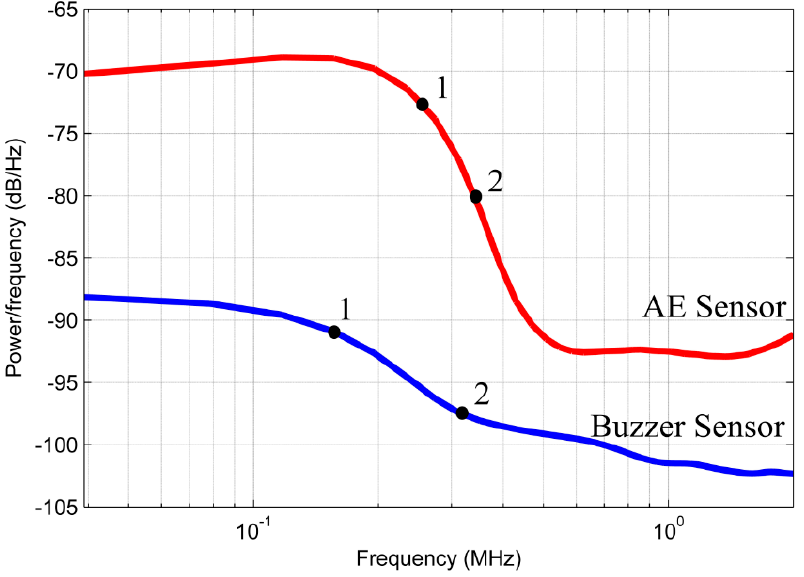
Figure 16. Power spectral density obtained for the low-cost and the conventional sensor.